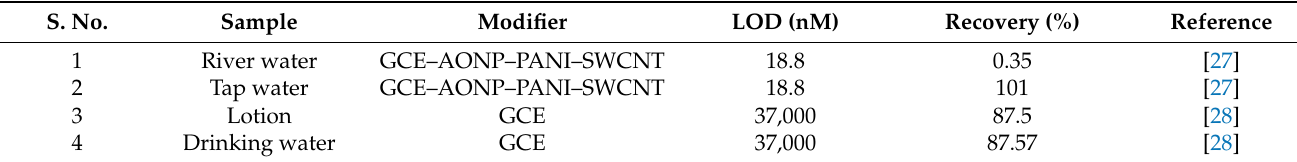
Table 1. Determination of lindane concentration in river water, tap water, lindane lotion, and drinking water using CV and